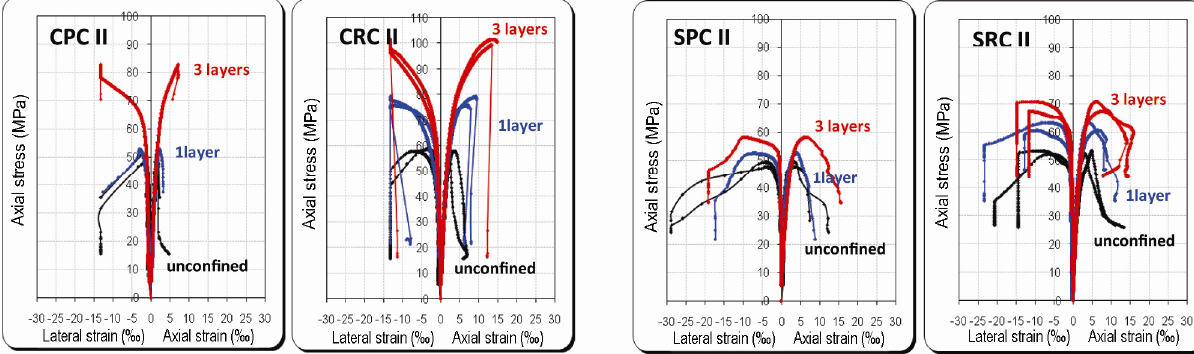
Fig. 9. Experimental stress strain curves of medium-strength concrete specimens ( f’ co = 50 MPa)